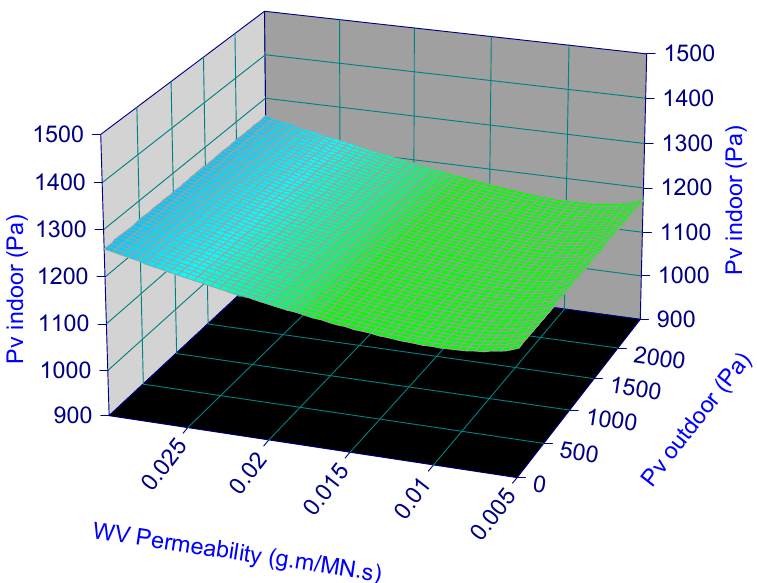
Figure 10. Indoor vapour pressure as a function of outdoor conditions and permeability during the occupied period.